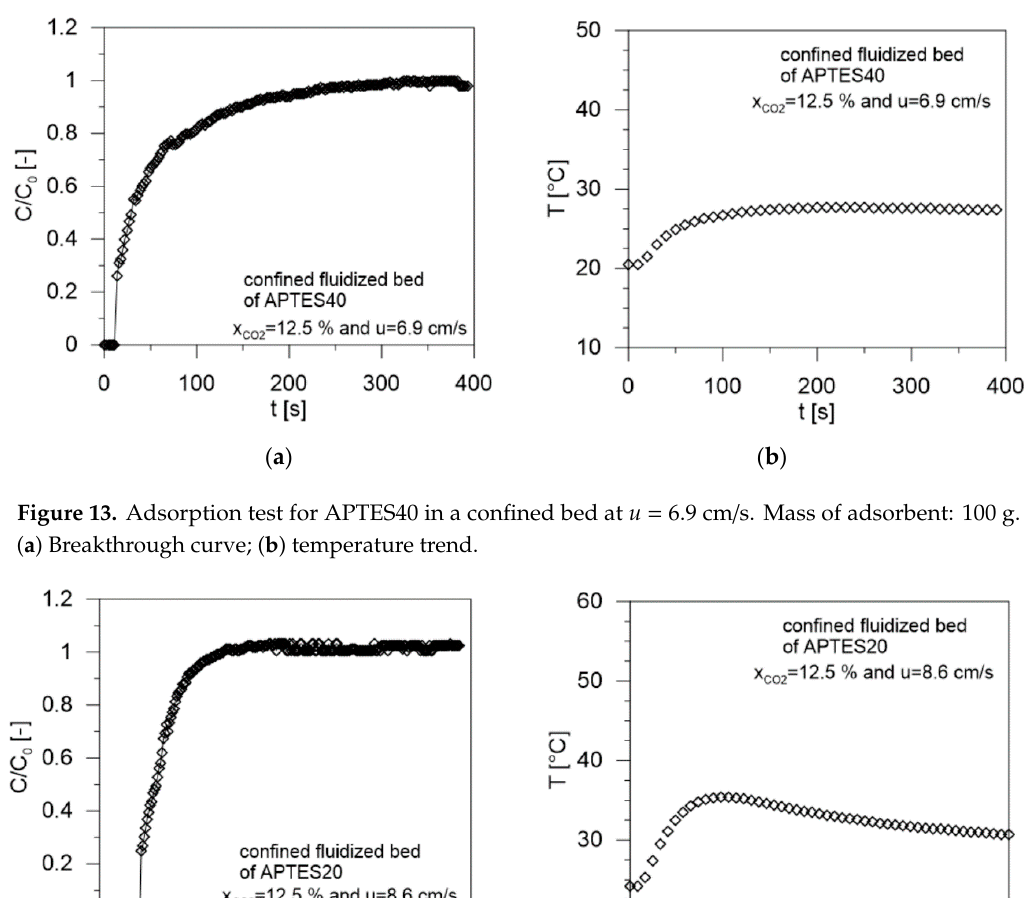
Figure 12. Adsorption test for APTES20 in a confined bed at u = 5.7 cm/s. Mass of adsorbent: 100 g. ( a ) Breakthrough curve; ( b ) temperature trend.